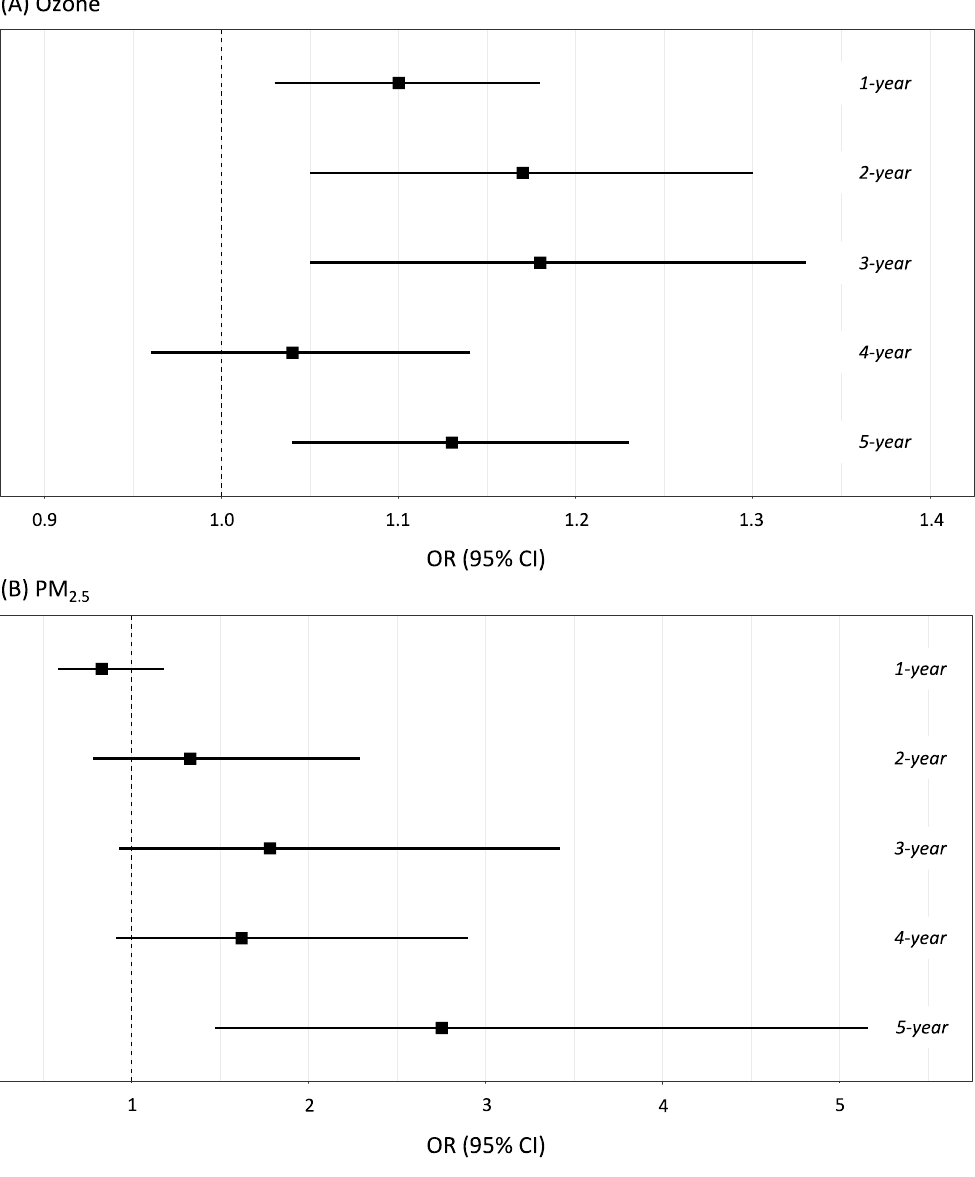
Figure 2. Associations between ozone ( A ) or PM 2.5 ( B ) levels and pCAD in participants from GEA Study. All models were adjusted for BMI, age, sex, education, smoking status, diabetes mellitus, HDL-cholesterol, LDL-cholesterol, systolic blood pressure, antihypertensive medication, total physical activity, locality, relative humidity, temperature and wind velocity. Odds ratio represents the risk for 1 ppb increase in ozone or 5 μg/m 3 increase in PM 2.5 .